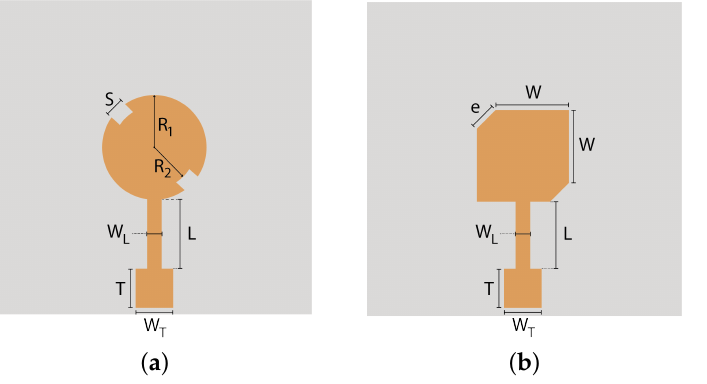
Figure 11. LHCP antennas made using SIGP for 5.8 GHz: ( a ) circular patch antenna and ( b ) squared patch